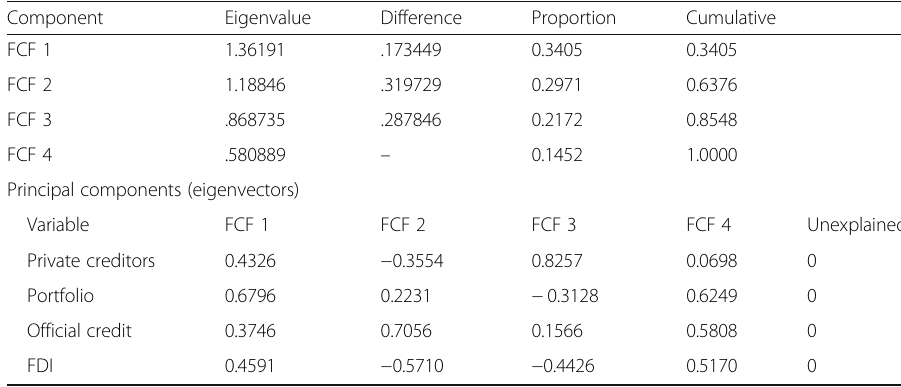
Table 15 Principal component analysis results for Foreign Capital Inflows (FCF)